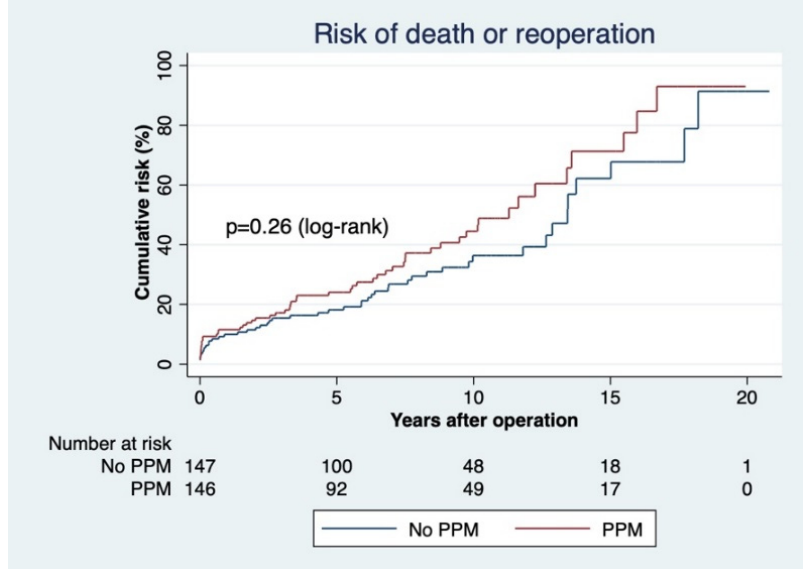
Figure 4. Composite risk of death or reoperation in the matched cohort according to the presence of patient–prosthesis mismatch (EOAi ≤ 0.85 cm 2 /m 2 ).